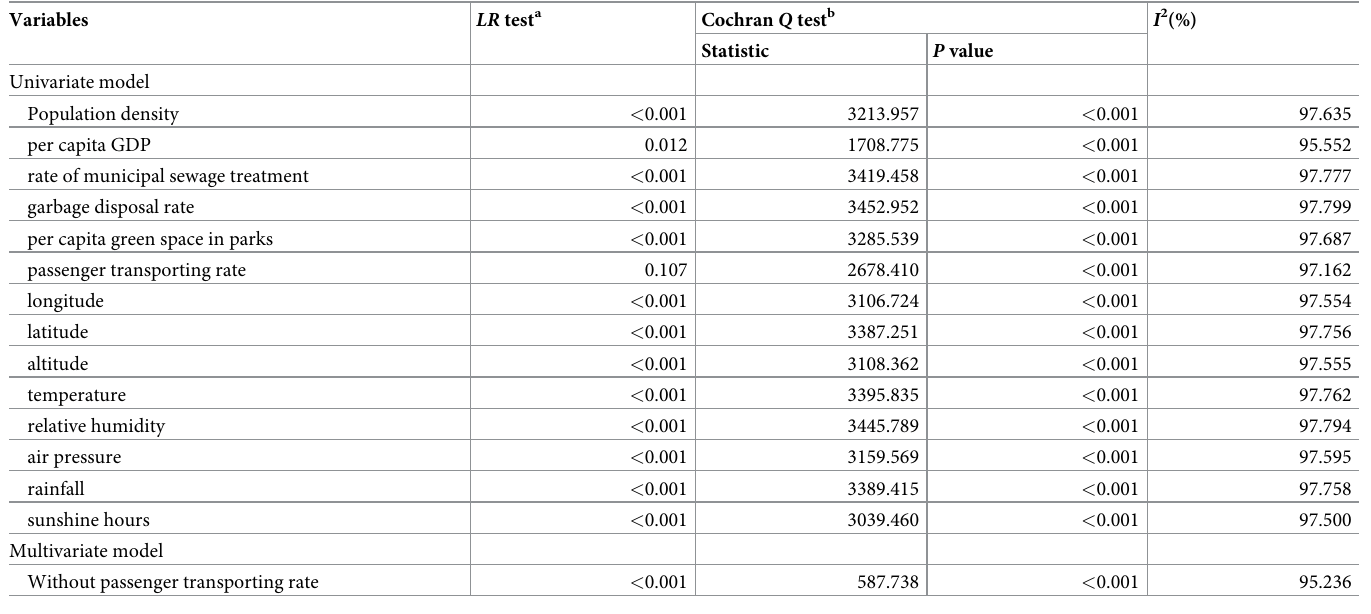
Table 3. Potential driven factors for the variance of DALY-temperature associations among cities.